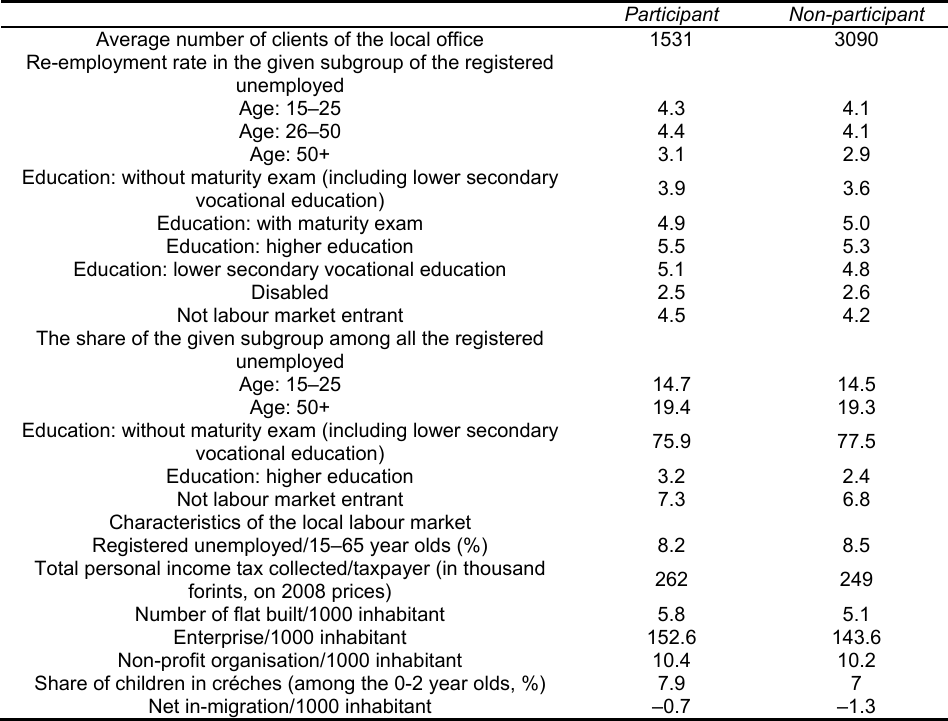
Table 2: Main observable characteristics of participating and non-participating local PES offices in the beginning of